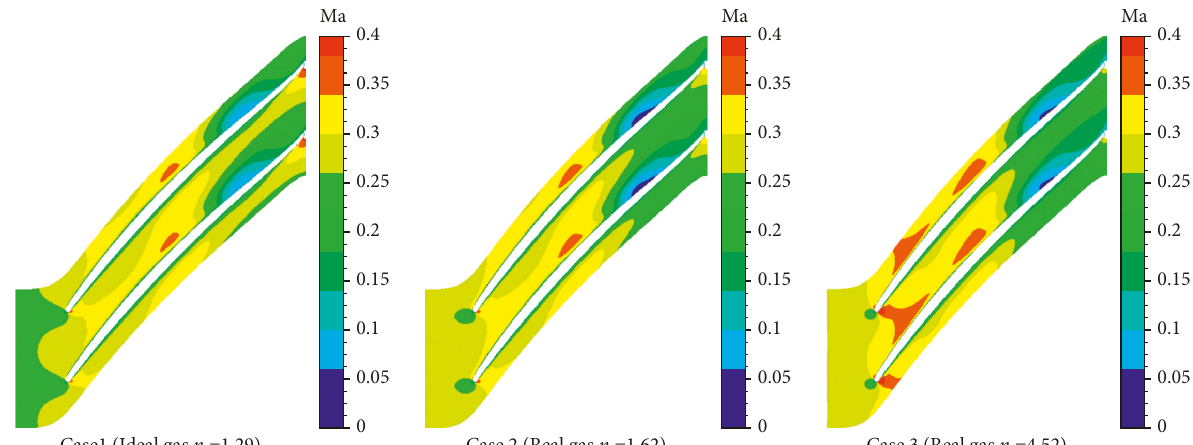
Figure 23: Mach number distribution of test cases (at 50% span).